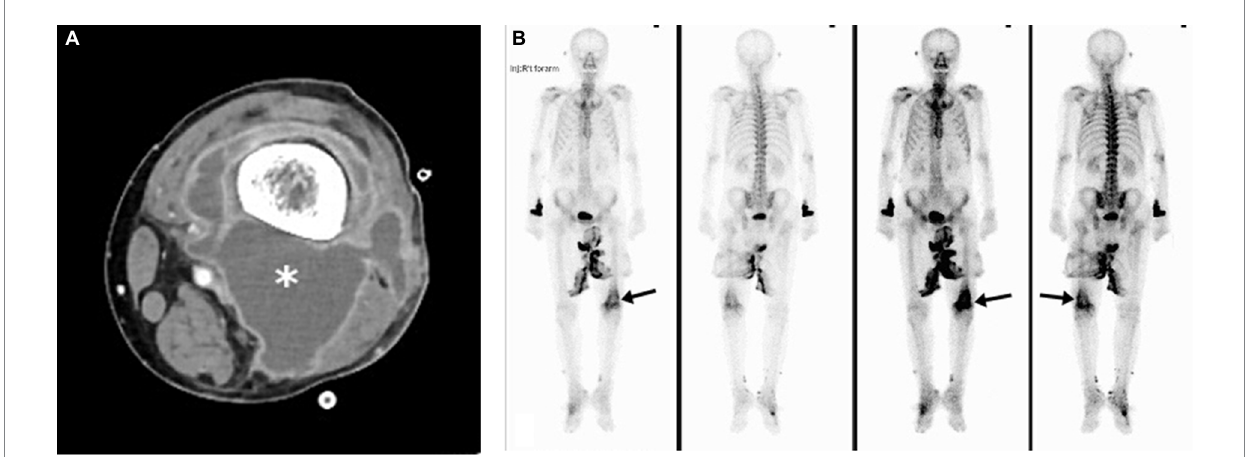
FIGURE 3 Melioidosis presented with septic arthritis of case 9. Contrast-enhanced axial computed tomography image showed marginal enhancing abscess-like accumulation in the right knee joint (asterisk) (A) . Tc-99 m MDP bone scan revealed marked-degree increased radiotracer uptake in the corresponding region (arrows) (B) .